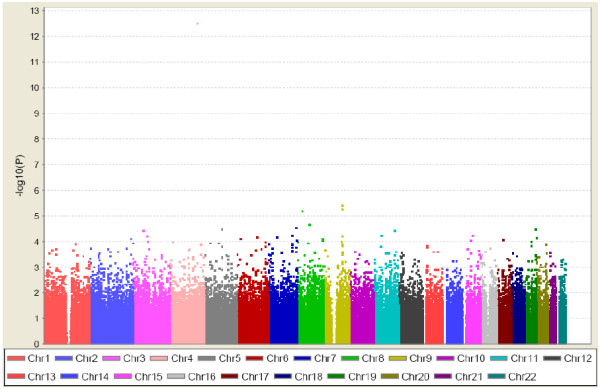
Genome-wide P-values (-log10P) of the logistic regression analysis plotted against chromosomal position.